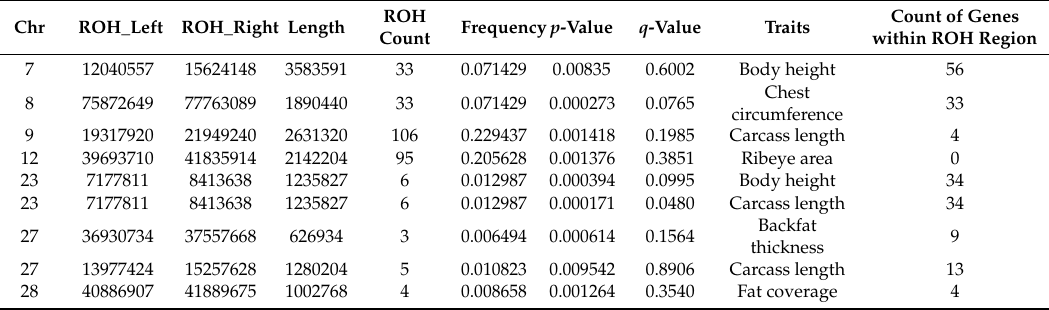
Summary of the associated ROH regions for important traits using a region-based association